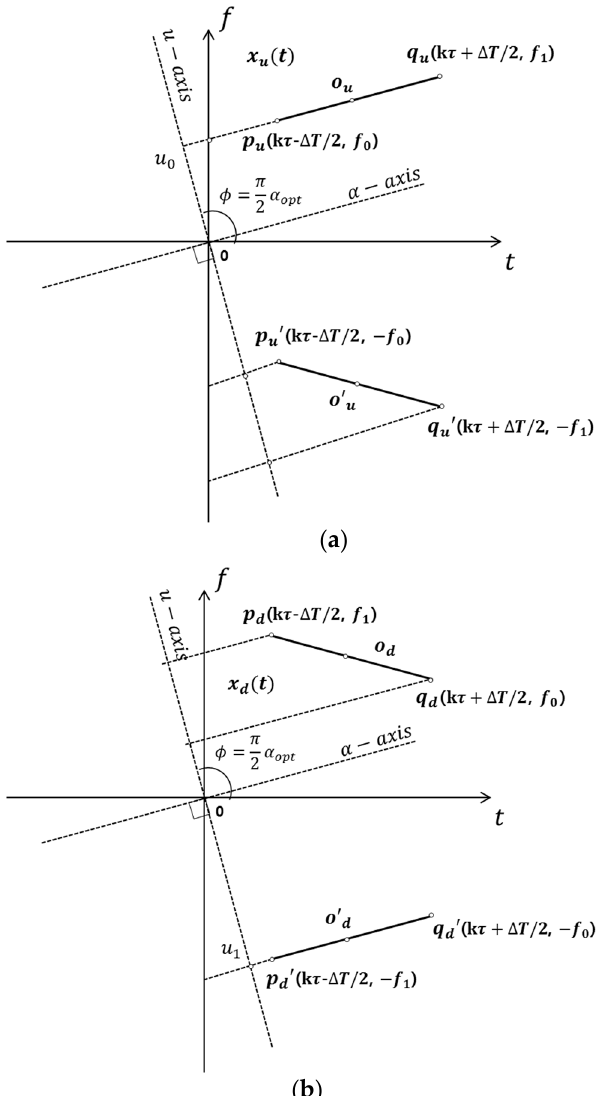
Figure 5. Relation between the chirp signal and FrFT coefficient α . ( a ) The up-slope chirp signal; ( b ) the down-slope chirp signal.